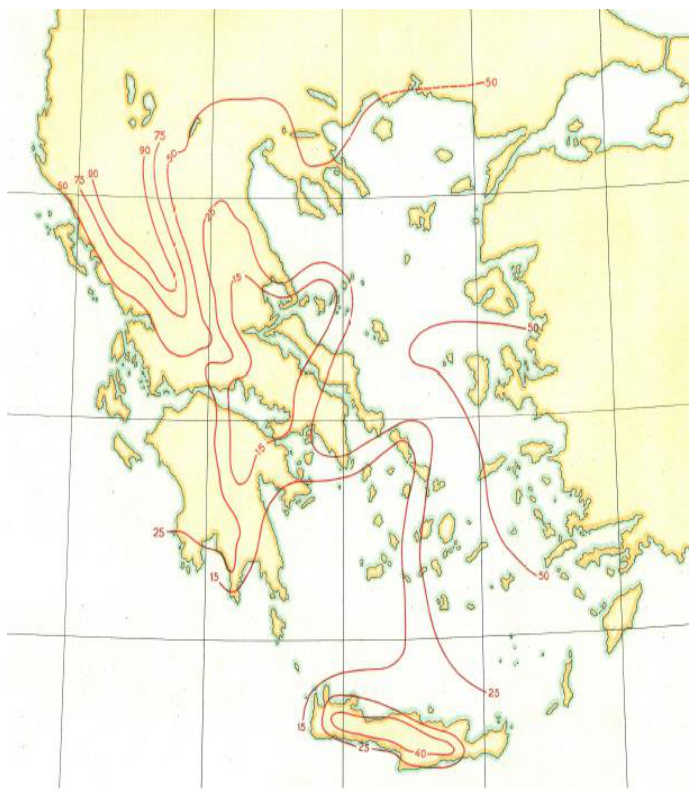
Figure 3. Isokeraunic map of Greece [20].